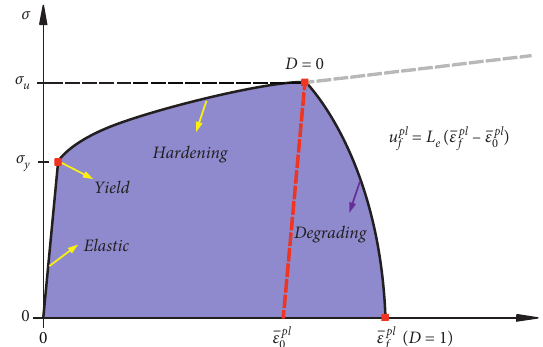
Figure 6: Progressive damage degradation model in ABAQUS [23].